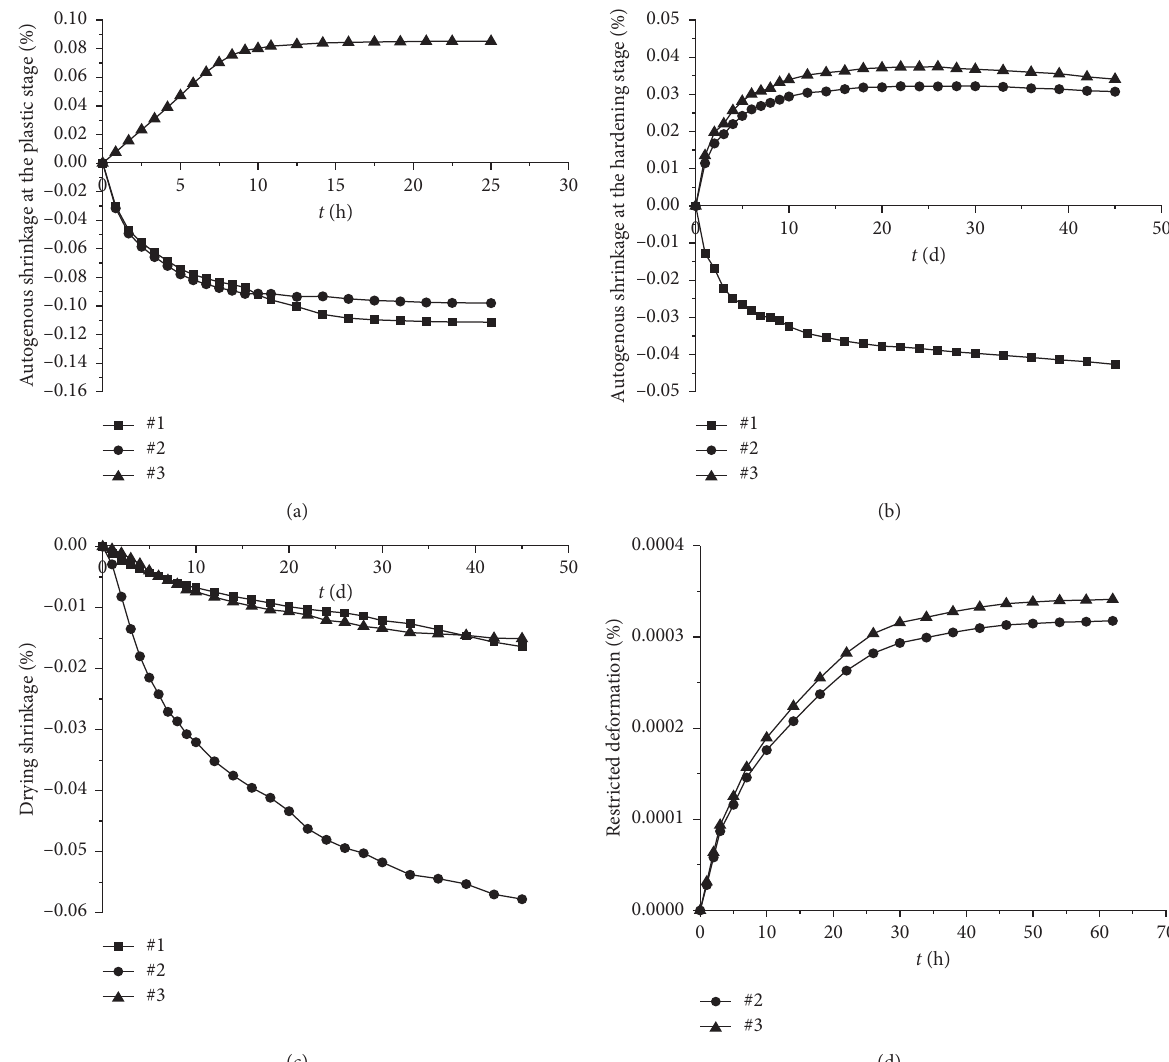
Figure 9: Volume stability test results for in-pipe concrete. (a) Autogenous shrinkage at the plastic stage. (b) Autogenous shrinkage at the hardening stage. (c) Drying shrinkage. (d) Restricted